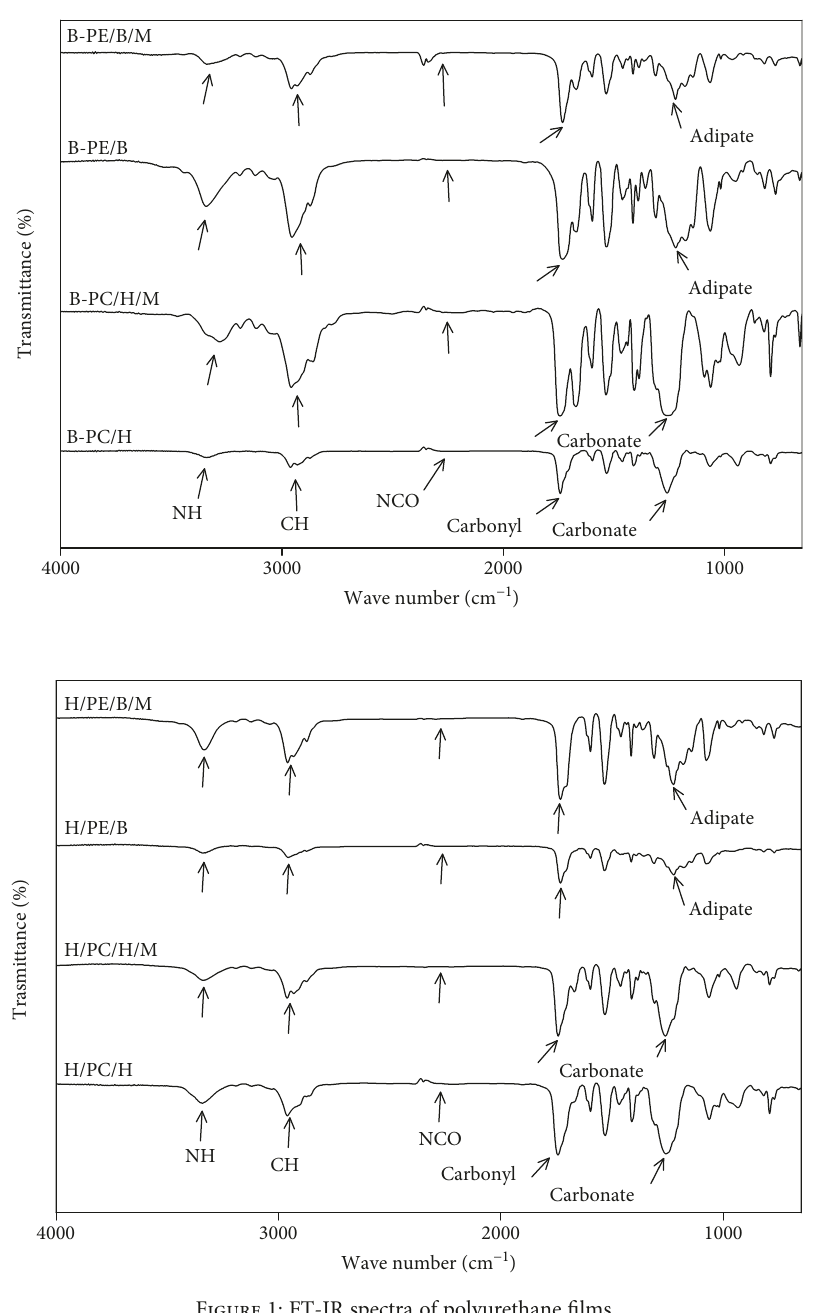
Figure 1: FT-IR spectra of polyurethane fi